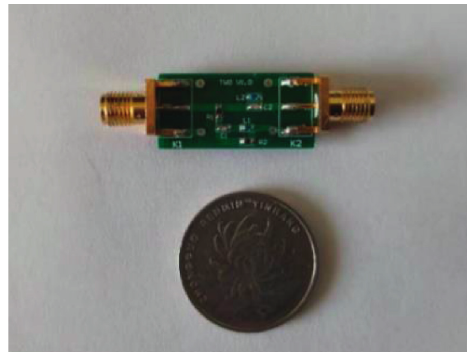
Figure 20: The fabricated band-stop filter circuit with band-pass negative group delay.